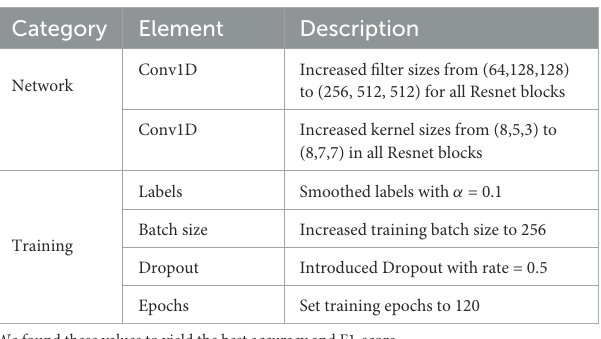
TABLE 5 Our hyperparameters tuning of the proposed optimized Resnet